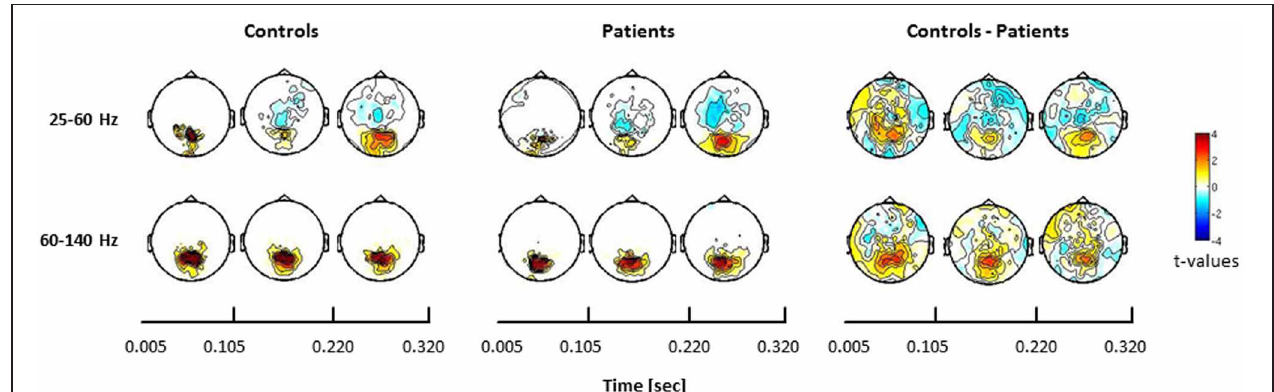
FIGURE 4 | Statistical analysis of power changes in response to upright Mooney faces for controls (left panel), schizophrenia patients (middle panel), and for the difference between controls and patients (right panel) for three time windows (onset-response, induced period, offset-response). The topographies for controls and schizophrenia patients show significant differences between the face condition and the 0.5s pre-stimulus baseline, separately for the lower (25–60Hz) and the higher (60–140Hz) gamma-band. Red denotes higher